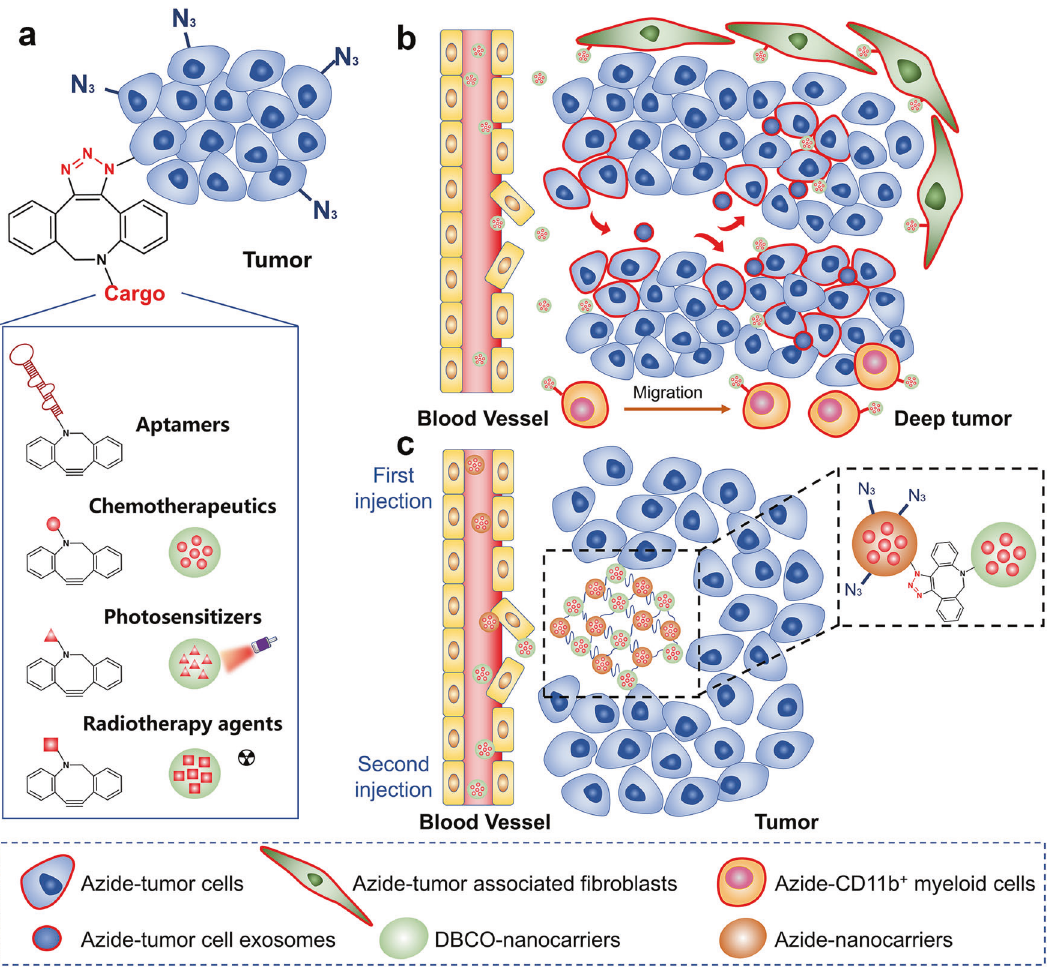
Fig. 3 Targeted delivery of anticancer therapeutics to tumor tissues via bioorthogonal chemistry. a Cancer-targeted delivery of therapeutics. b Increased intratumorally penetration of nanoparticles in three ways: 1. Labeling tumor-associated fi broblasts; 2. Tumor cell exosomes; 3. Migration of immune cells. c Construction of drug reservoirs in tumor tissues via bioorthogonal